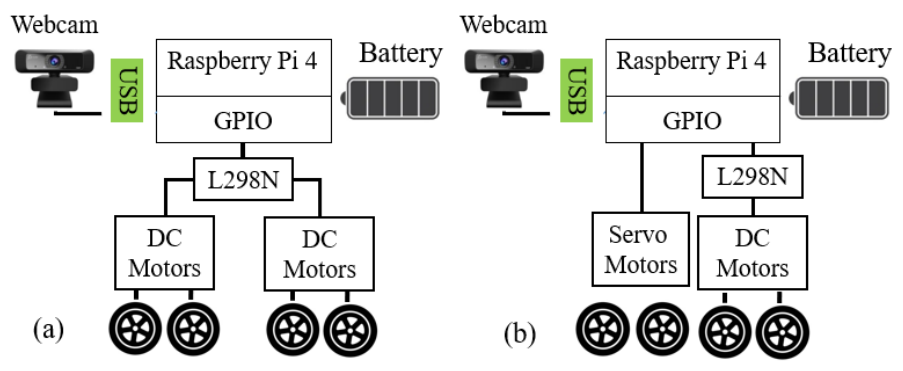
Figure 2. Hardware block diagrams of two vehicles, ( a ) Vehicle A is steered by controlling rotational speed differences between the left and right wheels, while ( b ) Vehicle B is steered by controlling the servo motor.